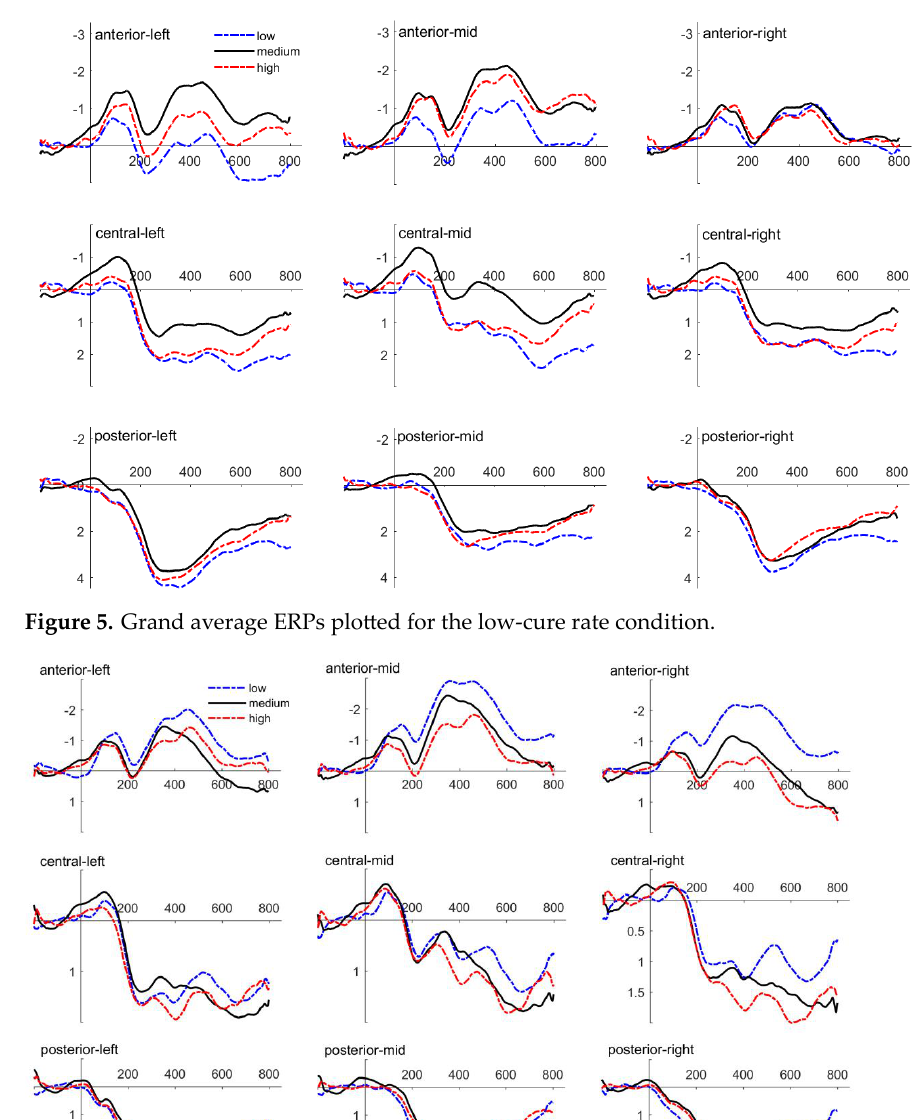
Figure 6. Grand average ERPs plotted for the medium-cure rate condition.